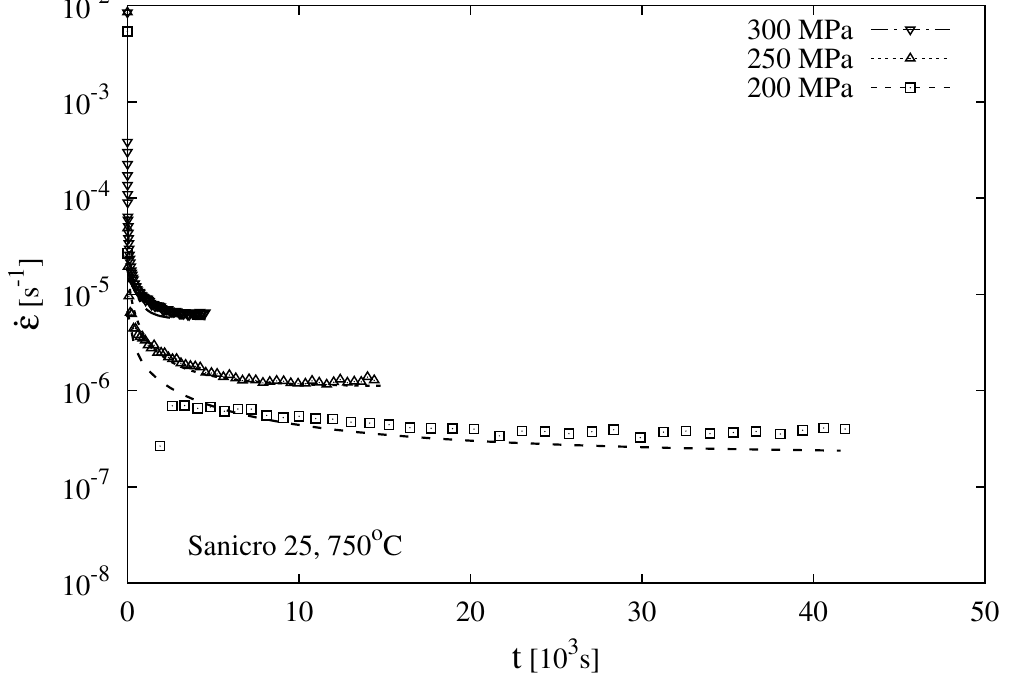
Figure 7. Creep rate dependence on time for Sanicro 25 at 750 ◦ C and high stresses [18] (points) compared to model results